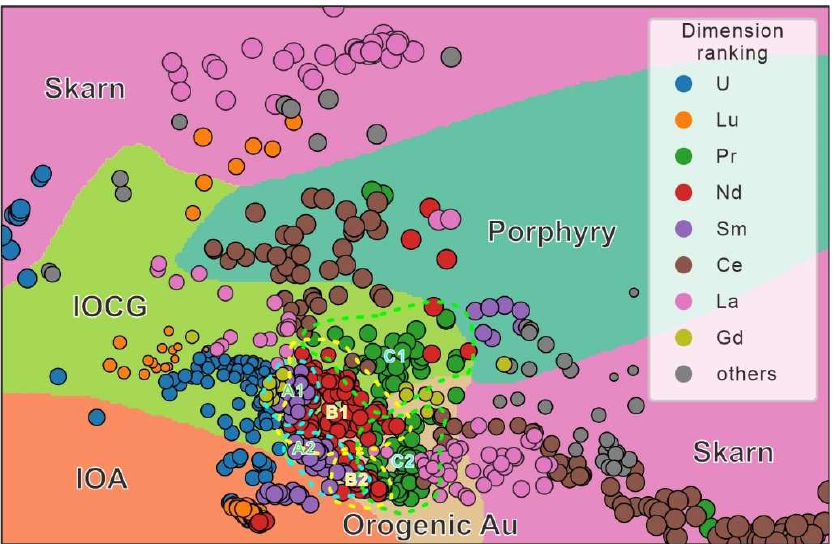
Figure 4. A-MPs diagram. A1, B1, and C1 are clusters of apatite samples in the IOCG deposit, and A2, B2, and C2 were clusters of apatite samples in the orogenic Au deposit. A2, B2, and C2 were clusters of apatite samples in the orogenic Au